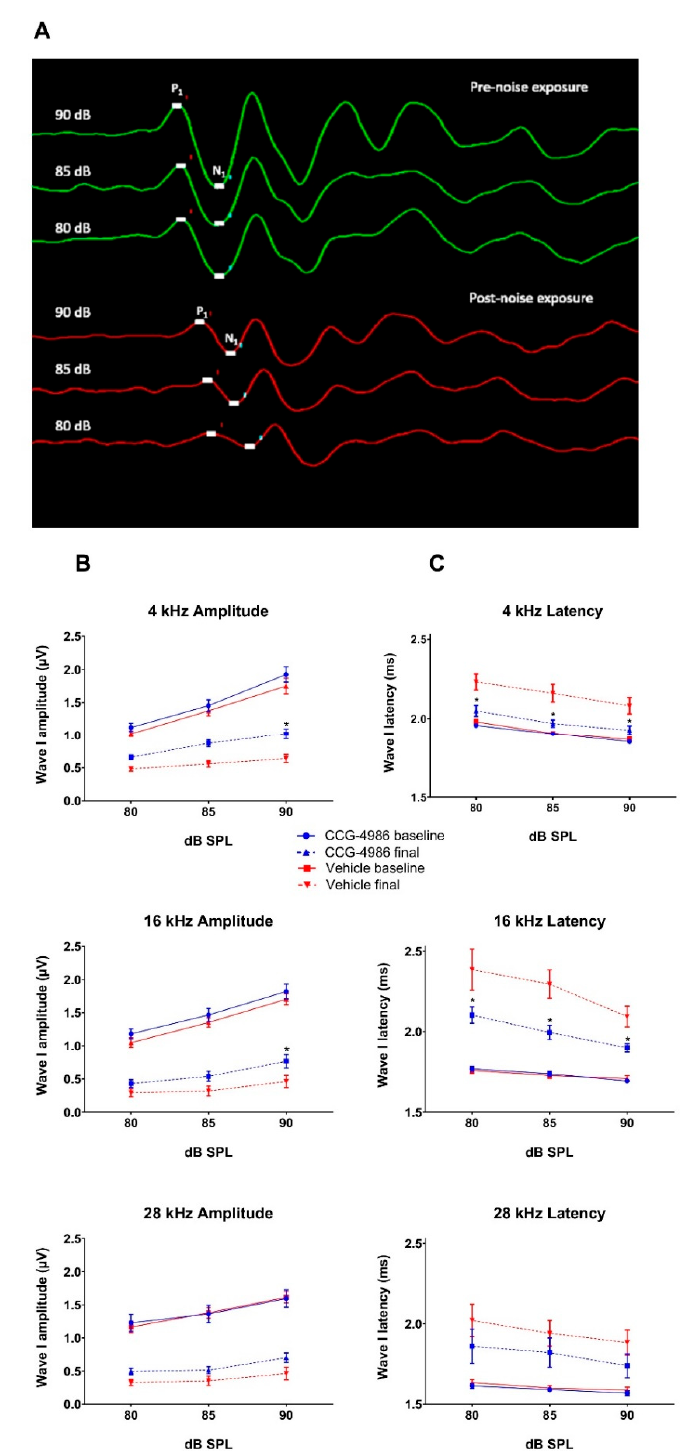
Figure 3. ( A ) Representative traces of ABR Wave I prior to noise exposure (green) and post-exposure (red). P 1 represents a positive peak and N 1 a negative peak. ABR responses were recorded at 16 kHz at suprathreshold intensities (80–90 dB SPL). Average baseline and final ABR wave I amplitudes ( B ) and latencies ( C ) at suprathreshold intensities in noise-exposed animals treated with CCG-4986 (100 µ M) or drug vehicle solution 48 h after noise exposure. Solid lines represent baseline amplitudes/latencies and dashed lines represent final amplitudes/latencies. Data presented as mean ± SEM, Vehicle control, n = 16; CCG-4986, n = 17. * p < 0.05; Multivariate ANOVA followed by planned contrast